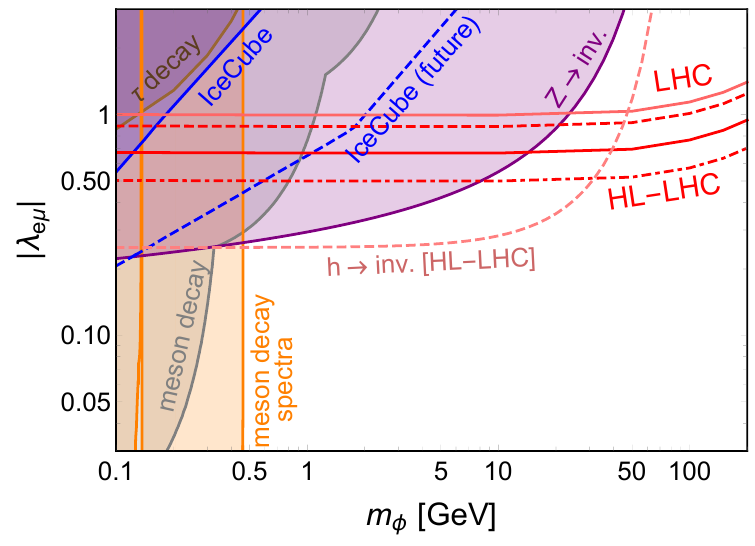
Figure 9 . The same as in (cid:12)gure 8, but for the coupling j (cid:21) e(cid:22) j